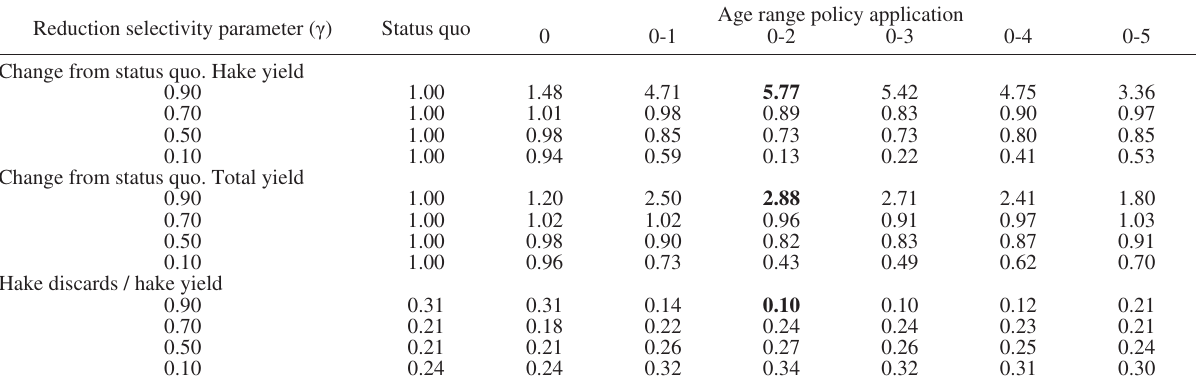
Table 2. – Improving age selectivity. Sensitivity analysis. Hake yield represents the stationary value of the hake catches (without discards) as defined by Equation 2. Total yield represents the stationary value of the sum of catches, in weight, of all species (without discards). All yield values are calculated for the optimal F under each scenario. The status quo represents the situation in which the selectivity parameter does not change ( γ = 0). Values in bold represent the best scenario for each variable. s,a Reduction selectivity parameter ( γ ) Change from status quo. Hake yield